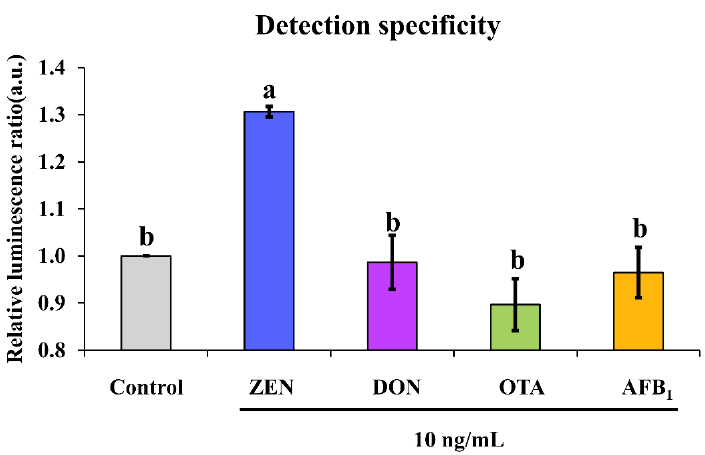
Figure 5. Detection specificity of our proposed sensing system. Note: different letters above bars indicate a significant difference ( p < 0.05) after one-way ANOVA followed by Fisher’s least significant difference test.